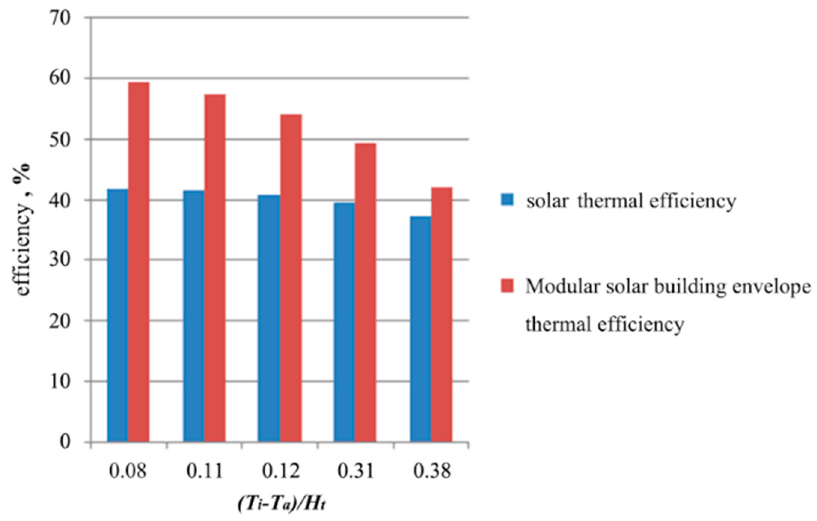
Figure 10. Efficiency comparison of module system and conventional solar thermal system.